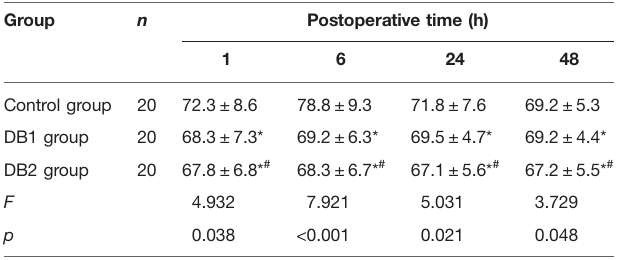
TABLE 3 | Comparison of diastolic blood pressure of puerperae at different times after surgery among three groups (mean±SD, mmHg).